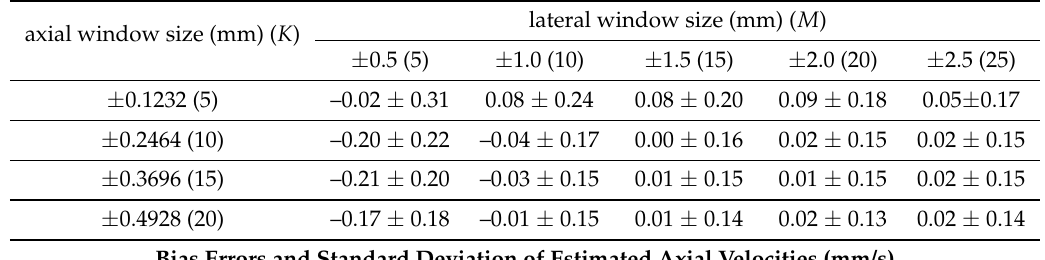
Table 9. Bias errors e bias and standard deviations σ of lateral and axial displacements at the same points shown in Figure 4a estimated by the conventional 2D motion estimator with frame averaging. Beamformed echo signals were obtained with rectangular apodization. Actual lateral and axial velocities were 1 mm/s and 0.5 mm/s, respectively.